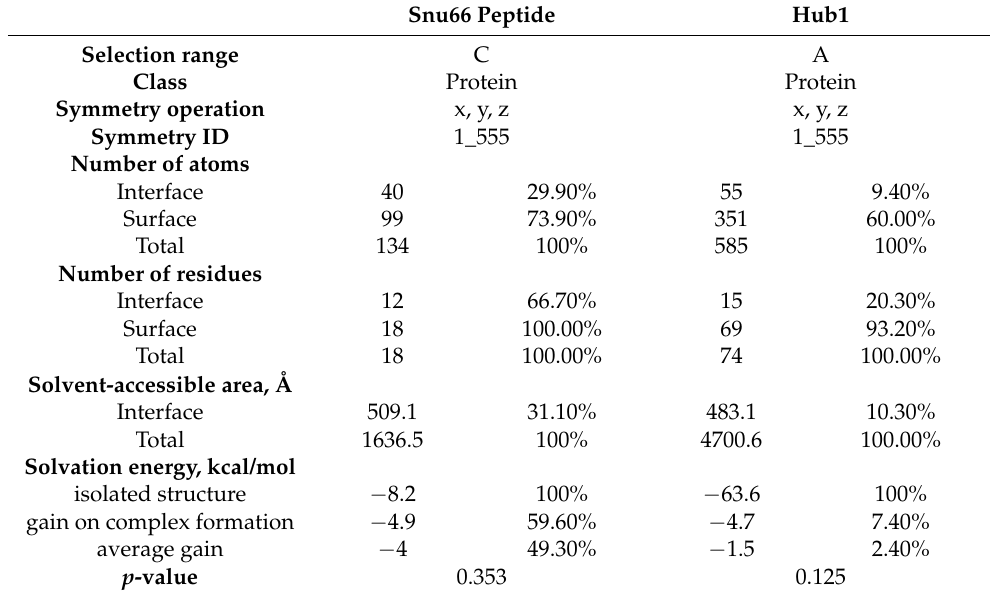
Table 1. Interface details estimated by